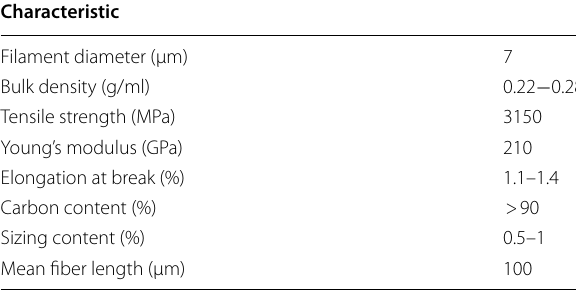
Table 3 Characteristics of milled carbon fiber.